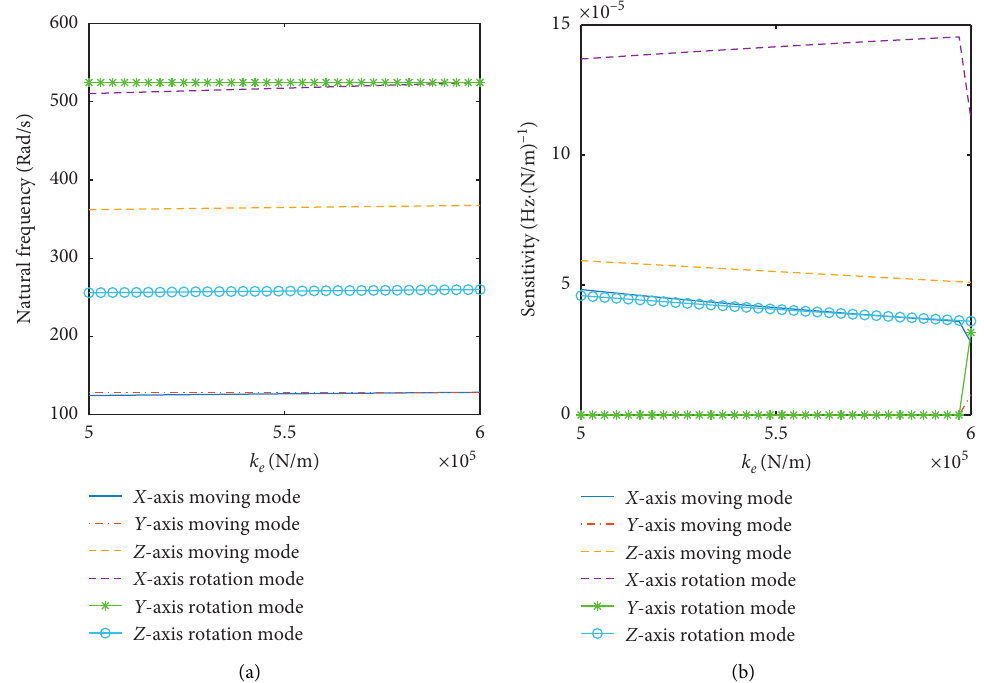
Figure 7: Curve of natural frequency and its sensitivity changing with the stiffness of outer leg 5. (a) Natural frequency. (b) Sensitivity of natural frequency to the stiffness of outer leg